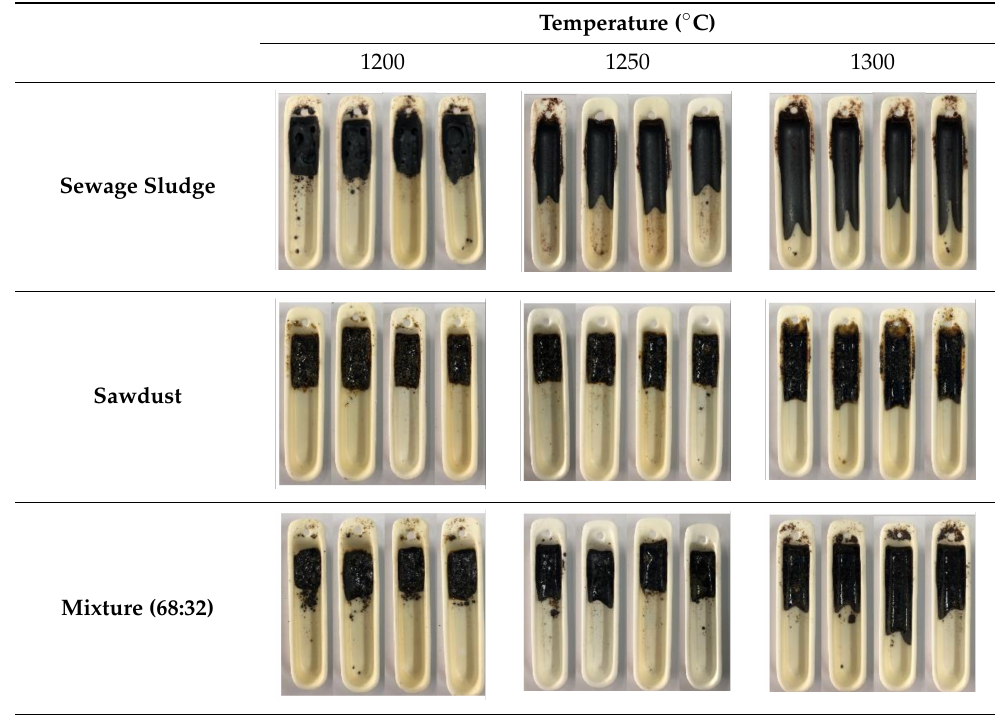
Figure 9. Results of pouring index at different temperatures ( (cid:3) : Mixture). Table 6. Images of pouring test